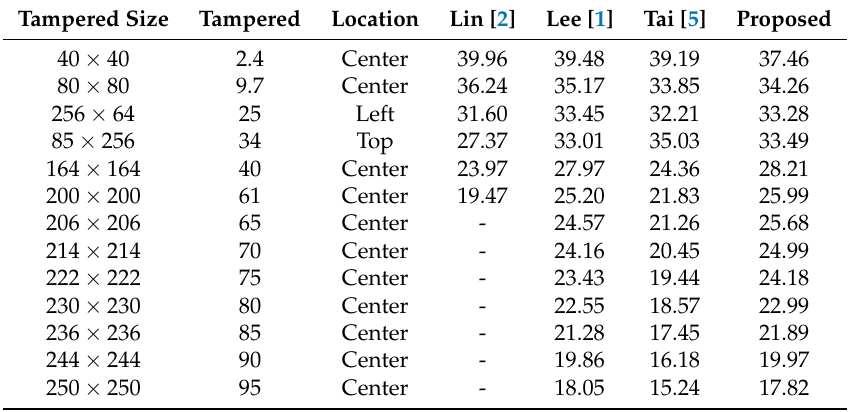
Table 3. The PSNR (dB) of the recovered image relative to the tampered size and location. Tampered Size